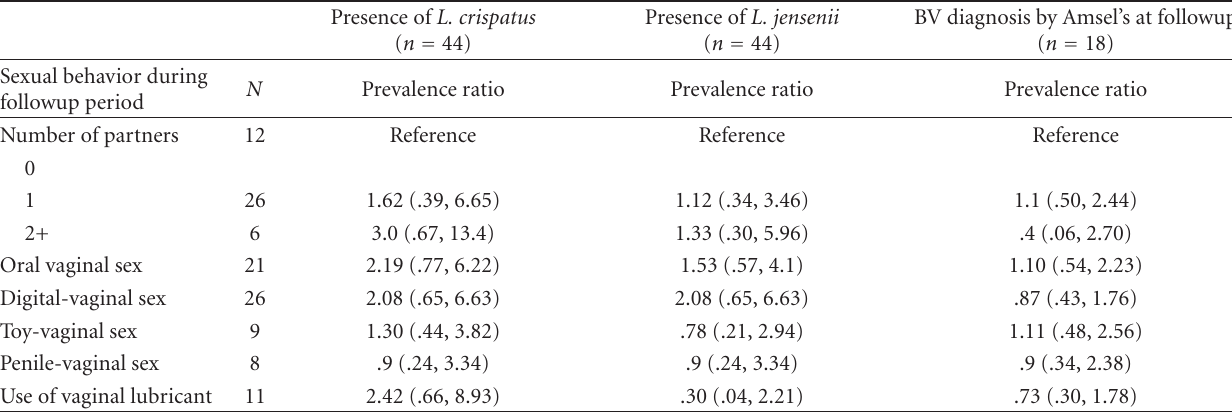
Table 1: Univariate association between reported sexual behaviors during treatment and followup and presence of L. crispatus or L. jensenii at the posttreatment visit.